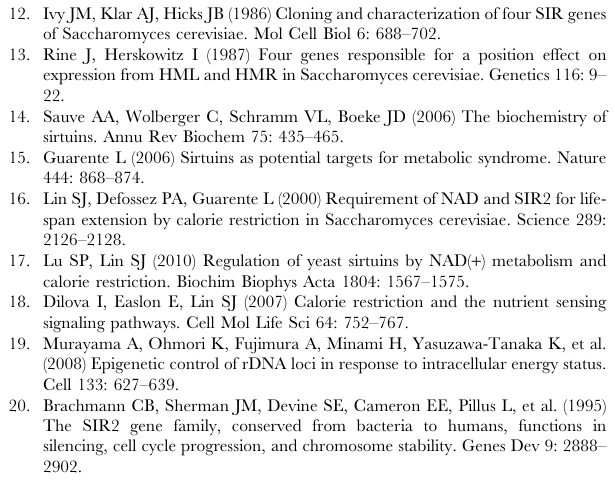
Figure S4 The entire metabolic profiling data set, including central carbon metabolism, for aged cells relative to young cells was mapped onto the network. Each graph was derived from the calculated amount of metabolic intermediates listed in Table S1. The blue and red columns indicate young and aged cells, respectively. Figure S5 Map of the central carbon metabolic pathway in budding yeast, based on the information from the Saccharomyces genome database (http://www.yeastgenome.org/). The gene(s) involved in each metabolic reaction are shown in red. Figure S6 The deletion of the TDH2 gene results in the inability of hst3 D hst4 D cells to extend their RLS. The RLSs of wild type, tdh2 D , hst3 D hst4 D and hst3 D hst4 D tdh2 D cells. The median lifespan is given next to each genotype. The difference between strains was performed on statistical calculations (Figure S1). Figure S7 The deletion of either the IDP1 or YAT1 gene can restore the growth of hst3 D hst4 D cells. ( A ) The growth curve of wild type, hst3 D hst4 D , idp1 D , and hst3 D hst4 D idp1 D cells in SD medium. ( B ) The growth curve of wild type, hst3 D hst4 D , yat1 D , and hst3 D hst4 D yat1 D cells in SD medium. Figure S8 The entire metabolic profiling data set, including central carbon metabolism, for hst3 D hst4 D cells relative to wild type cells was mapped onto the network. Each graph was derived from the calculated amount of metabolic intermediates listed in Table 3. Blue column: wild type; red: hst3 D hst4 D ; green: tdh2 D ; orange: tdh2 D hst3 D hst4 D . Figure S9 FBP1 expression is induced in both wild type and tdh2 D cells in response to ethanol (EtOH). RNA was prepared from cells treated with either glucose or EtOH as a carbon source. Reverse transcription polymerase chain reaction (RT-PCR) was employed to measure the ratio of FBP1 mRNA to ACT1 mRNA. All graphs represent the mean of triplicate experiments. The error bars denote the standard deviation.